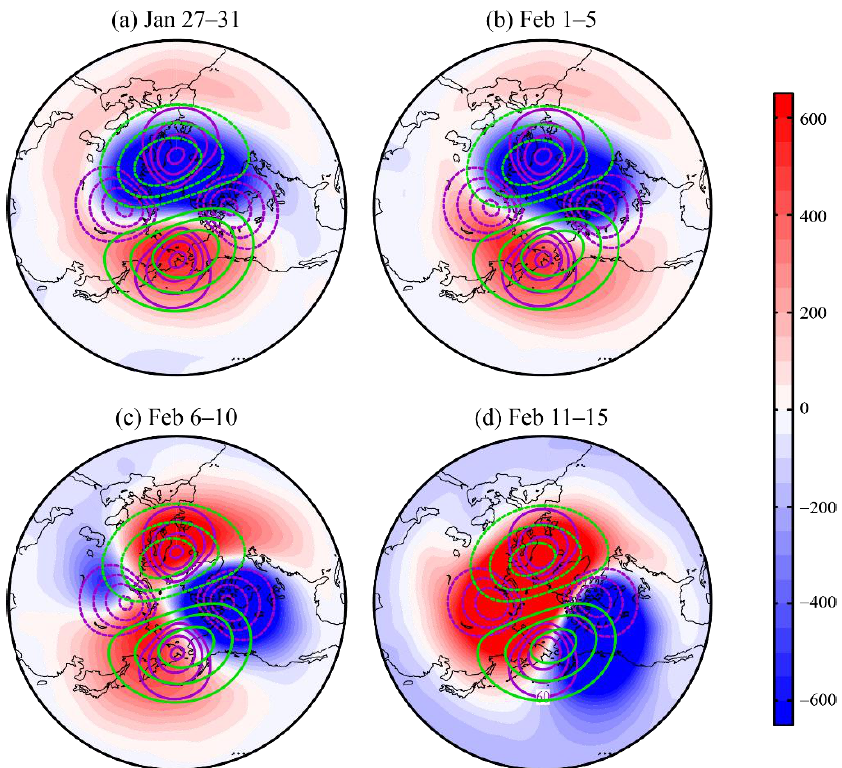
Figure 4. 10-hPa geopotential height anomalies averaged over each successive 5 days from 27 January to 15 February (shading, unit: gpm). Light green (purple) contours are the corresponding climatological wavenumber-1 (wavenumber-2) components. The contour levels for wavenumber 1 (wavenumber 2) are successively ± 200, ± 400, and ± 600 gpm ( ± 60, ± 90, ± 120, ± 150 gpm).